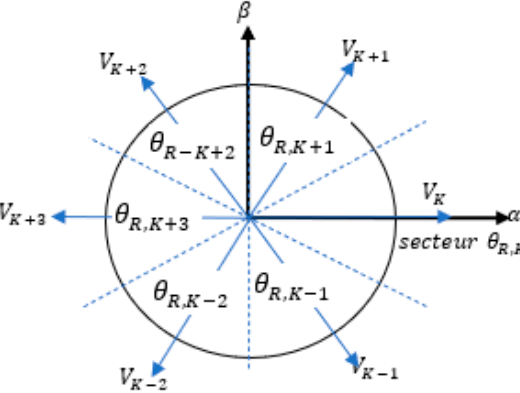
Figure 8. 6-sector tension plane in the frame ( α - β ).